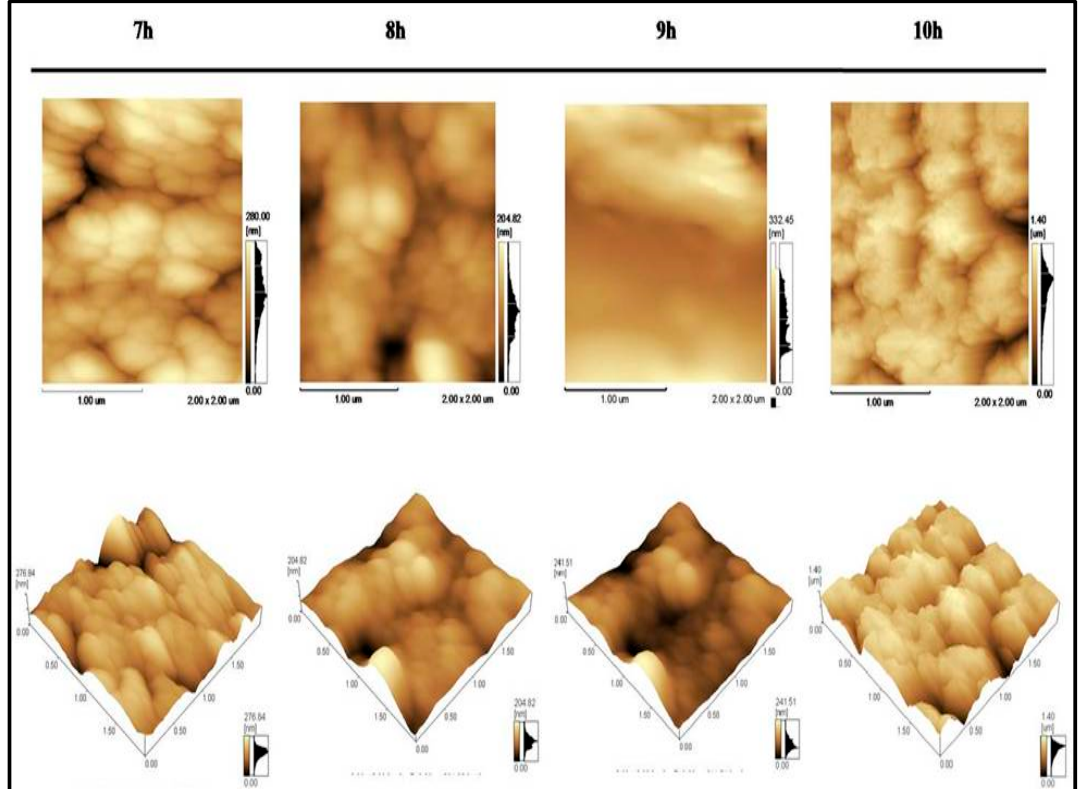
Figure 5. Images obtained in an atomic force electron microscope (AFM) after anodization process in NH 4 F 0.25% + glycerol at 30 V for 7, 8, 9, and 10 h. The annealing process was performed at 530 ◦ C (5 ◦ C / min) for 1